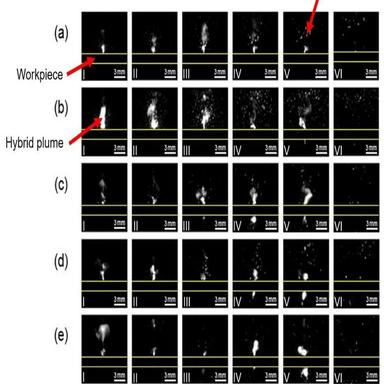
High-speed photography images showing the transient evolution of blind-hole drilling or through-hole drilling using the third laser pulse with different pulse energies of (a) 0.5 J, (b) 1 J, (c) 1.5 J, (d) 2 J and (e) 2.5 J.